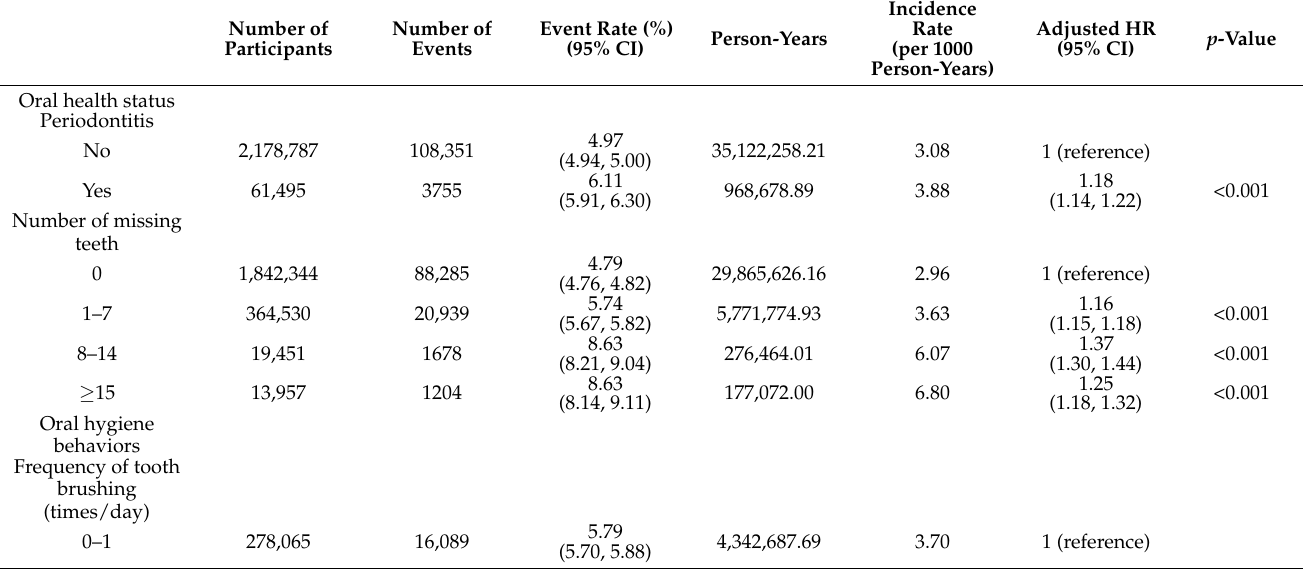
Figure 2. Kaplan–Meier survival curves for the occurrence of Meniere’s disease according to the oral hygiene and behavior indicators. ( a ) Periodontitis ( p < 0.001). ( b ) The number of missing teeth ( p < 0.001). ( c ) The frequency of tooth brushing (times/per day) ( p < 0.001). ( d ) Dental scaling within the previous year ( p = 0.003). Table 2. The risk of the occurrence of Meniere’s disease according to the oral health status and oral hygiene